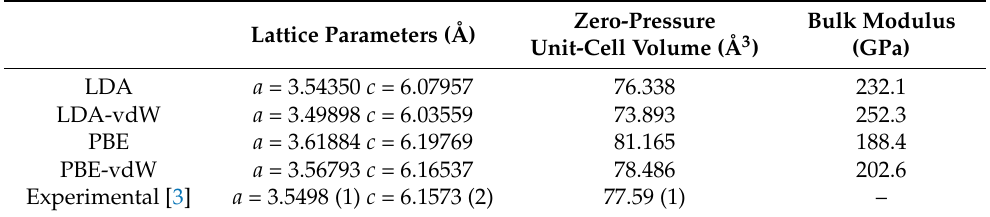
Table 1. Theoretical lattice parameters and unit-cell volume at room pressure, and bulk modulus for zaccariniite (RhNiAs) as obtained from different combinations of DFT calculations.